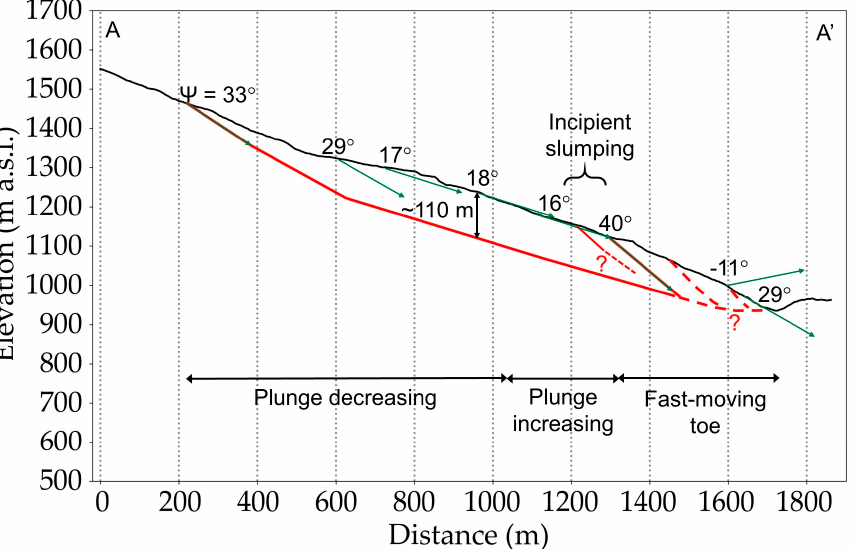
Figure 10. Section of the Fels sliding surface along profile A-A’ in